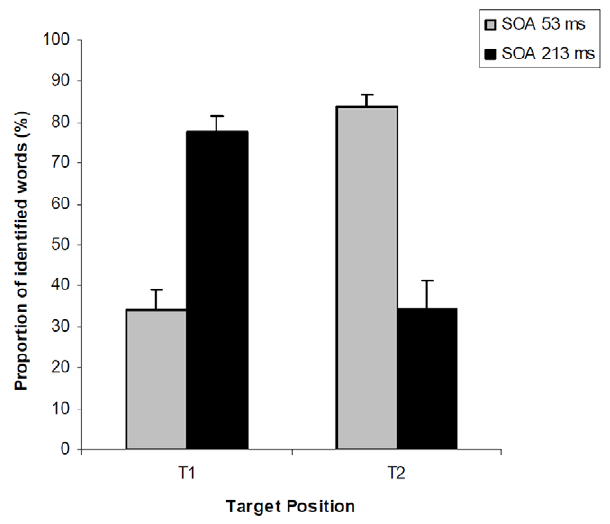
Figure 2. The ability to detect a target word depends on the target position (T1 and T2) and the time separating the onset of the two targets (SOA). Paired t -tests comparisons showed that when the stimulus onset asynchrony (SOA) is short (53 ms) T2 is better reported than T1 ( t 17 = 12.56, P , .001). On the reverse, when the SOA is longer (213 ms, 3 distractors between T1 and T2), T1 is better reported than T2 ( t 17 = 7.47, P , .001). Error bars indicate s.e.m.